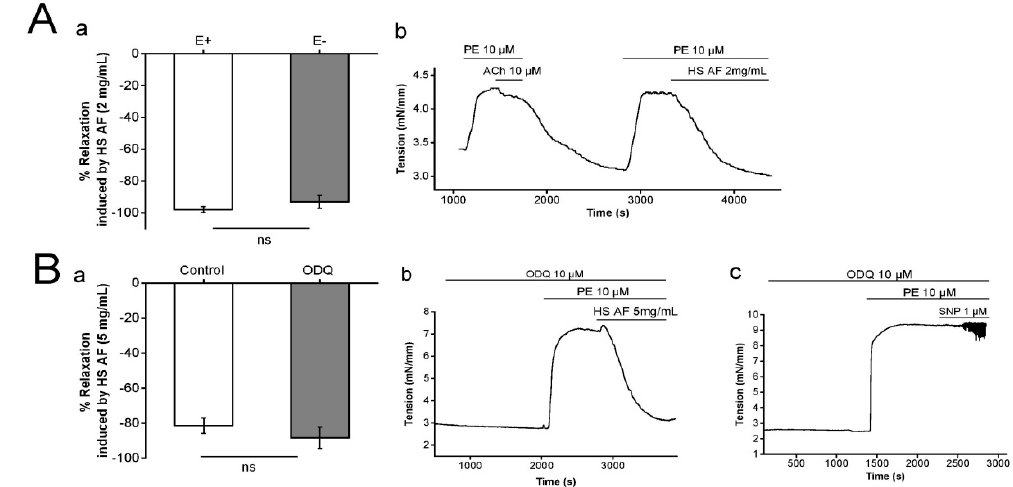
Figure 4. ( Aa ) Relaxant effect of 2 mg/mL HS AF on isolated Wistar rat MA ring pre-contracted by 10 µM PE in endothelium-intact (E+) and endothelium denuded (E − ) rings. ( Ab ) Representative experimental trace of HS AF effect compared to 10 µM ACh-induced relaxation. Values are expressed as mean ± SEM (n = 8/4 for intact rings and n = 9/5 for denuded rings). ( Ba ) Effect of 5 mg/mL HS AF on isolated Wistar rat MA rings pre-contracted by 10 µM phenylephrine (PE) in presence and absence of 10 µM ODQ. ( Bb ) Representative experimental trace. MA rings were perfused with ODQ for 20 min before pre-contraction. ( Bc ) Control experiment by use of sodium nitroprusside (SNP) 1 µM. Values are expressed as mean ± SEM (n = 13/7 for control (PE + HS AF), n = 8/4 for 10 µM ODQ + (PE + HS AF)). Relaxation was calculated as a percentage of the initial contraction. Not statistically significant (ns).